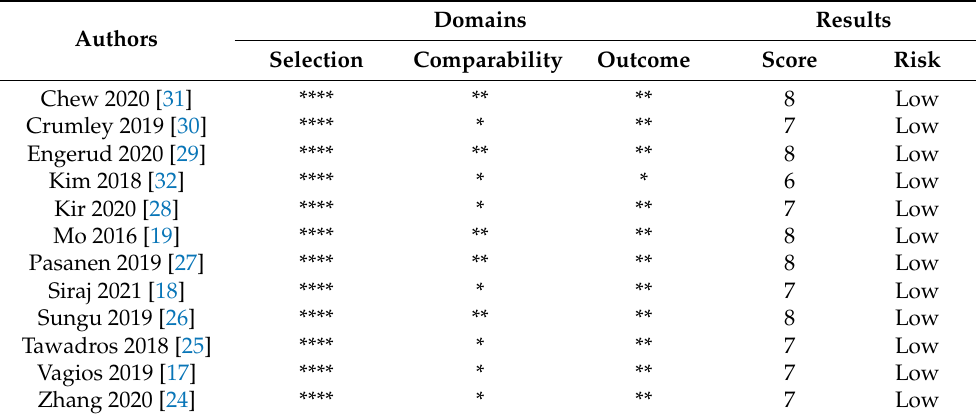
Table 1. The risk of bias (NOS